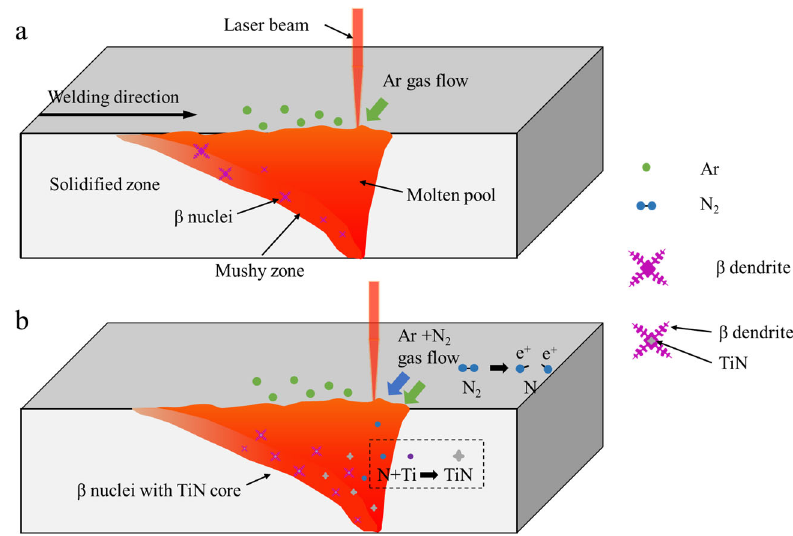
Figure 6. Schematic presentation of the nucleation condition in ( a ) sample 1# and ( b ) sample